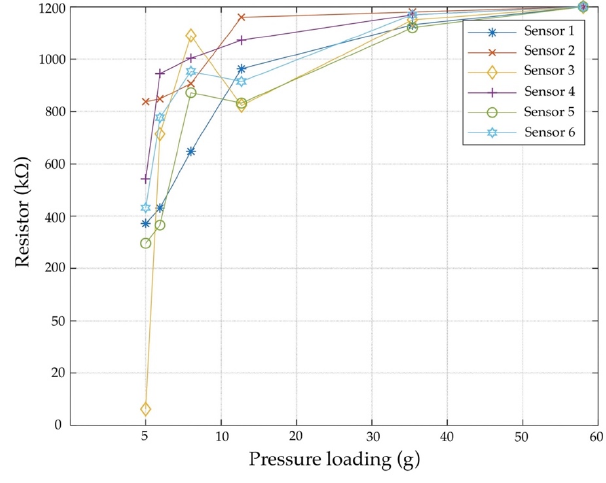
Figure 13. Pressure sensor response test.